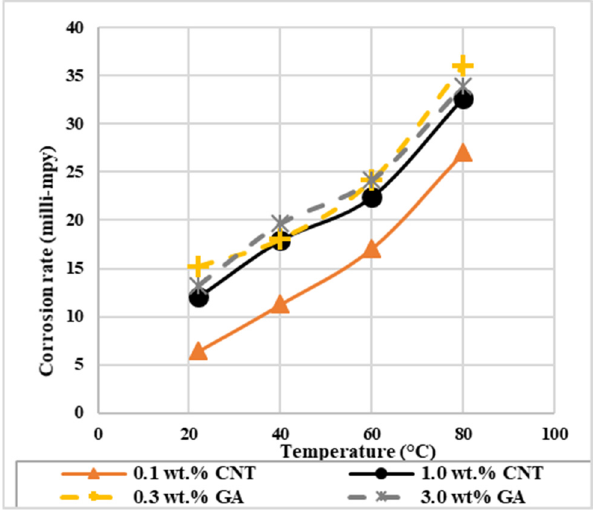
Figure 4. The effect of temperature on the corrosion rate of 316L stainless steel exposed to CNTs–water nanofluids and GA-deionized water solutions of different concentrations.